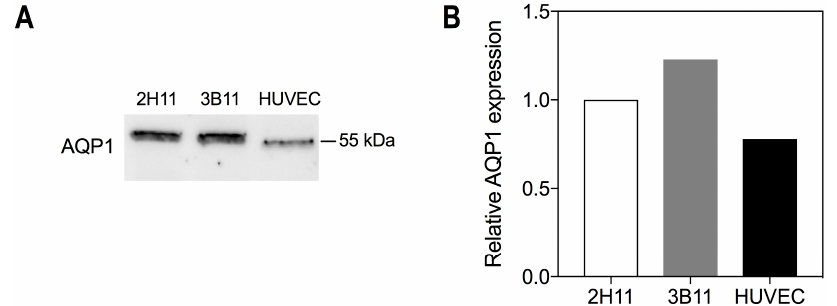
Figure 1. AQP1 expression in endothelial cell lines. ( A ) Western immunoblot confirming AQP1 protein expression in mouse endothelial cell lines 2H11 and 3B11 and human endothelial cell line HUVEC; ( B ) Quantification of AQP1 bands in ( A ), standardized relative to 2H11 and normalised to total